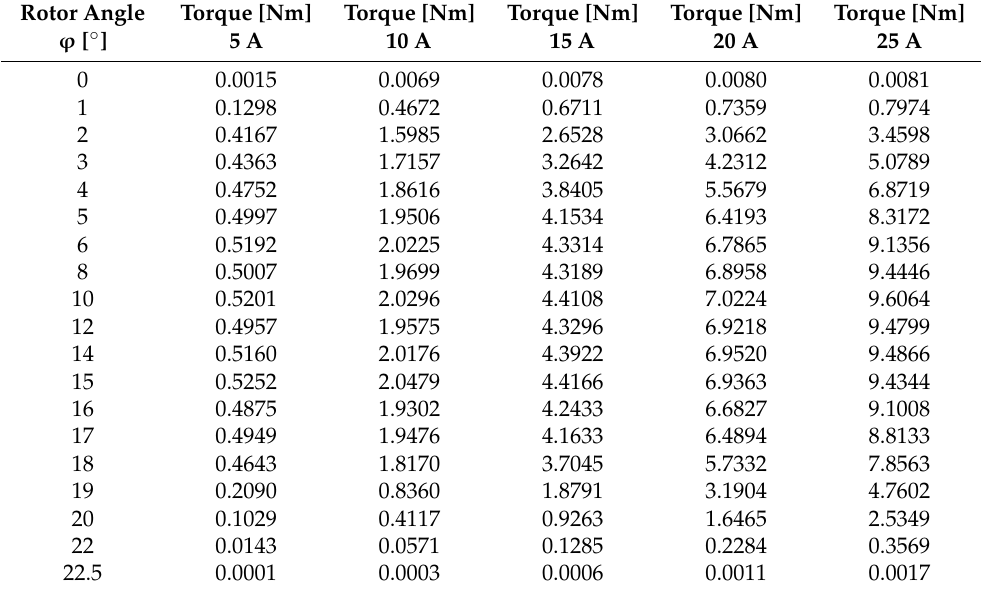
Table 7. The 10/8 motor: torque values for individual angles’ and currents’ values derived from the